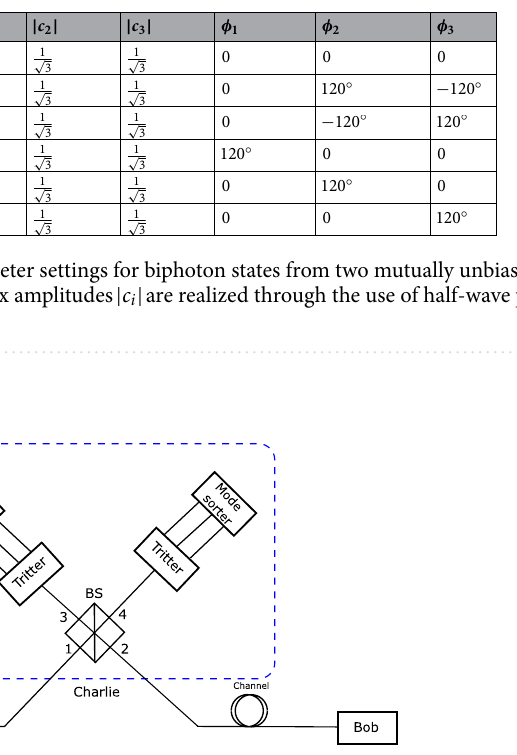
Figure 2. The generic measurement set up for our proposed MDI-QKD. Alice and Bob start by preparing the biphoton states from two mutually unbiased bases and send them through the unsecured channel to Charlie. Charlie allows the states to interfere in the symmetric beam-splitter (BS) upon receiving the states. The photons are directed towards the tritter and eventually detected in the Brown Twiss scheme (mode